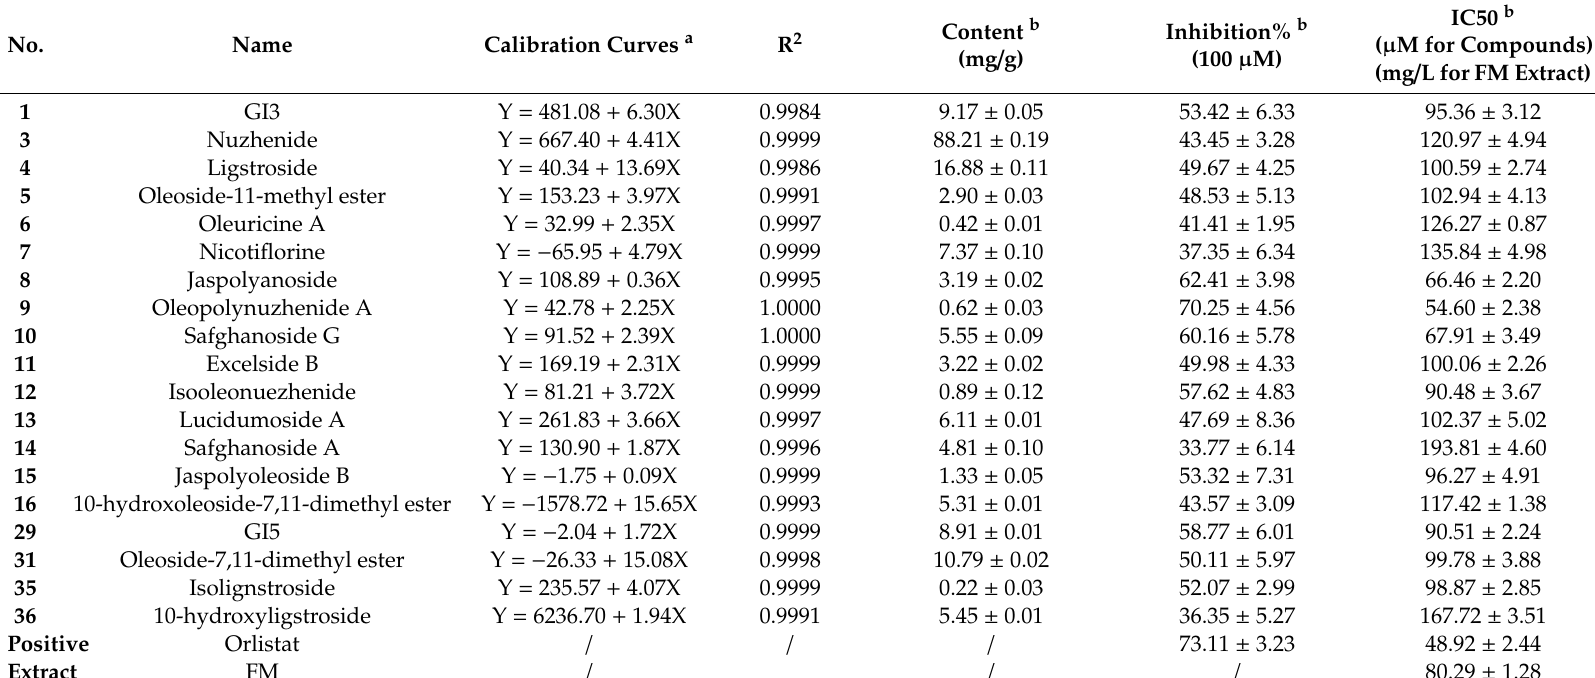
Table 1. Contents and pancreatic lipase inhibitory activity of